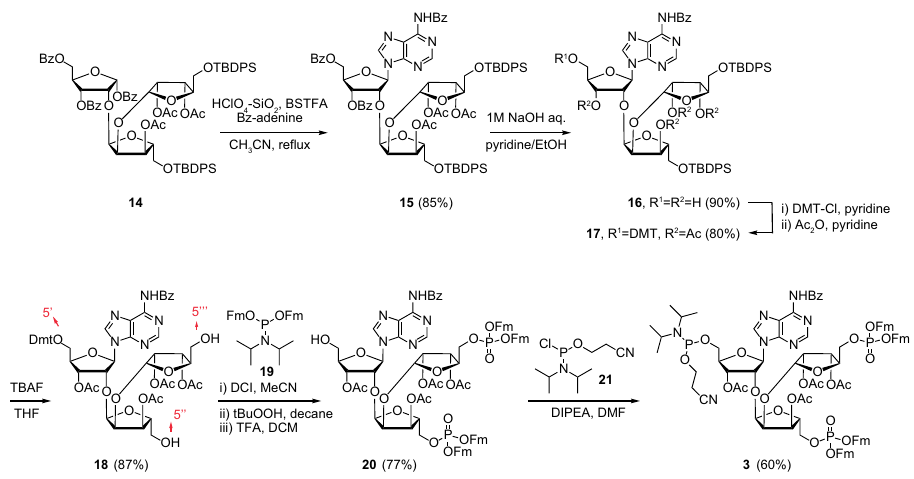
Fig. 3 Synthesis of branch point phosphoramidite (3). Parotriose derivative 14 is converted into nucleotide 15 via a Vorbrüggen type glycosylation after which phosphate and phosphoramidite functionalities are installed at the primary hydroxyls of the ribose residues. Red: the arrows show the notation for the three distinct 5-OHs. Yield after each step is given as percentage in brackets. HClO 4 -SiO 2 perchloric acid on silica gel, BSTFA N , O -bis(trimethylsilyl) tri fl uoroacetamide, DMT 4,4 ′ -dimethoxytrityl, TBAF tetra - n -butylammonium fl uoride, DCI 4,5-dicyanoimidazole, t BuOOH tert -butyl hydroperoxide, TFA tri fl ouroacetic acid, DIPEA N , N -Diisopropylethylamine, DMF